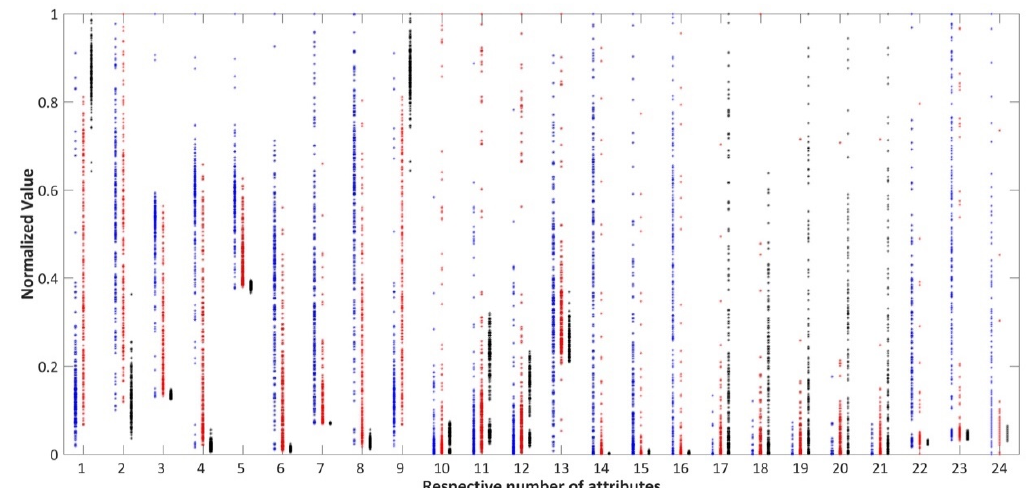
Figure 8. Normalized values of each attribute calculated from 642 training signals.